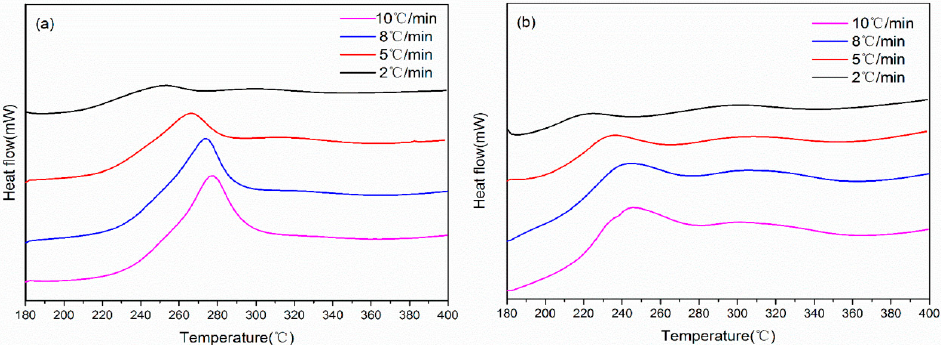
Figure 2. DSC curves of ( a ) PAN and ( b ) irradiated PAN fibers at different heating rates of 2, 5, 8 and 10 °C/min in air atmosphere.